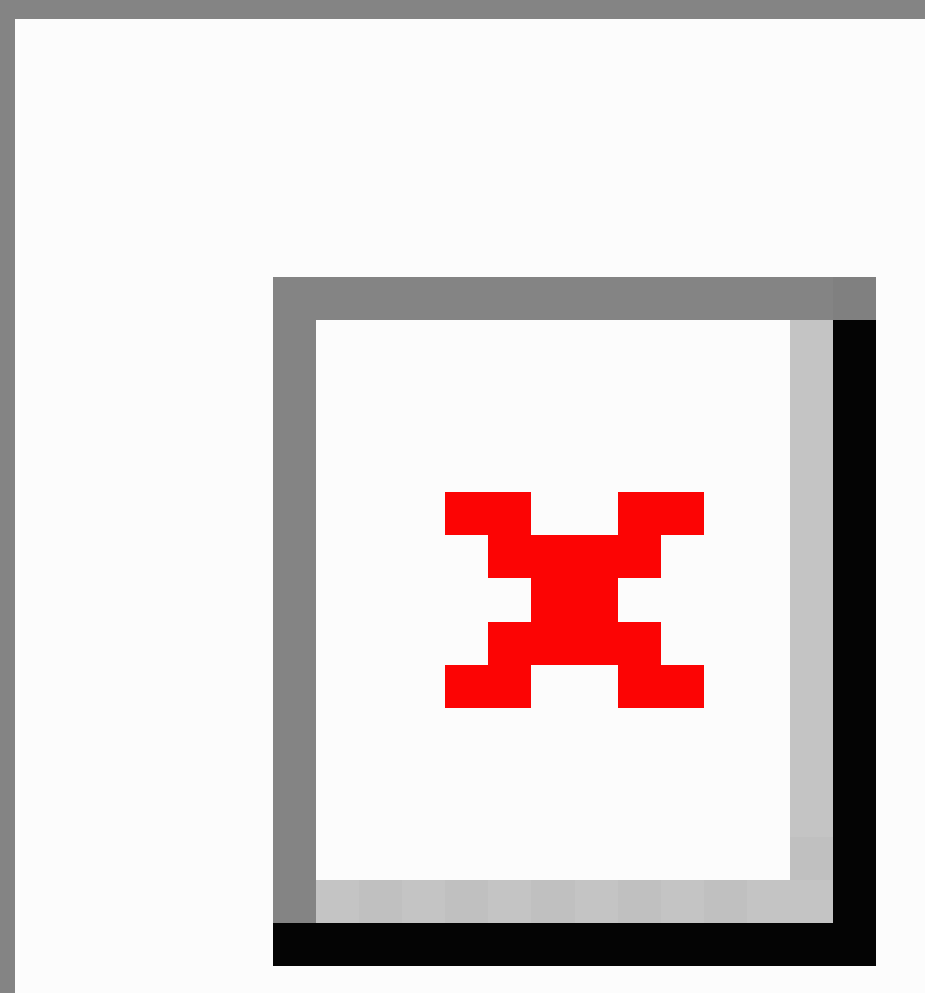
Figure 2. Initial data and work flow of the school absenteeism reporting